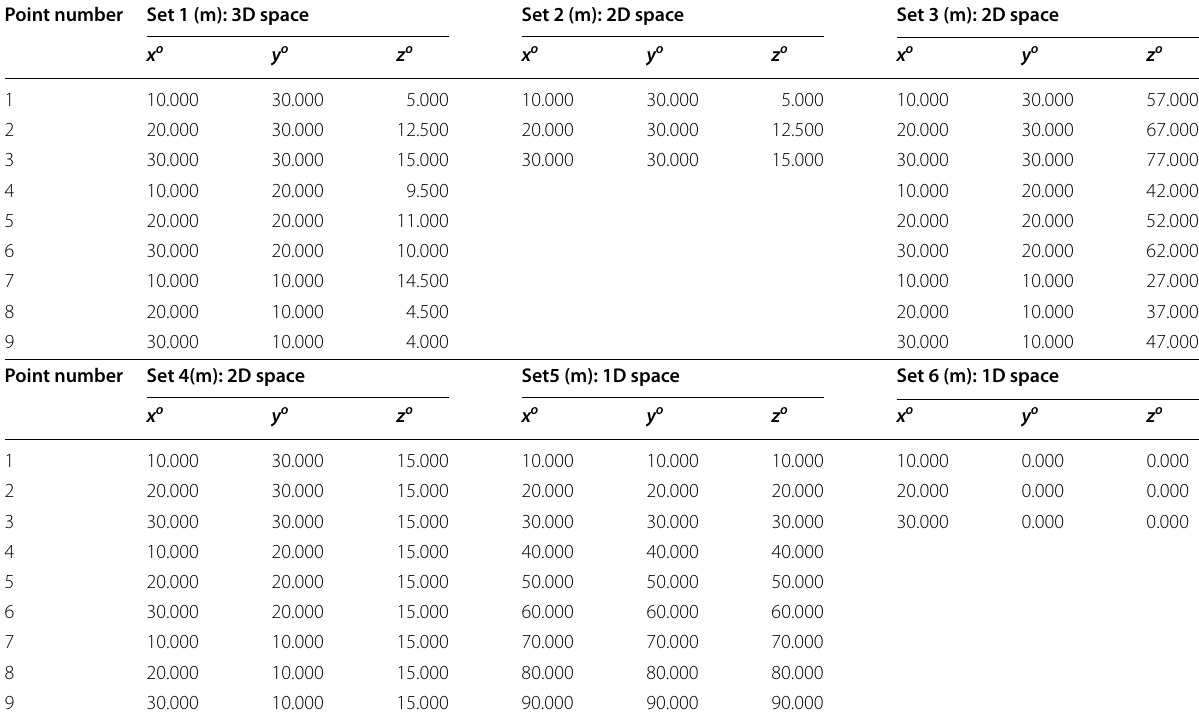
Table 9 Simulative true coordinates of control points in the original system Point number Set 1 (m): 3D space Set 2 (m): 2D space